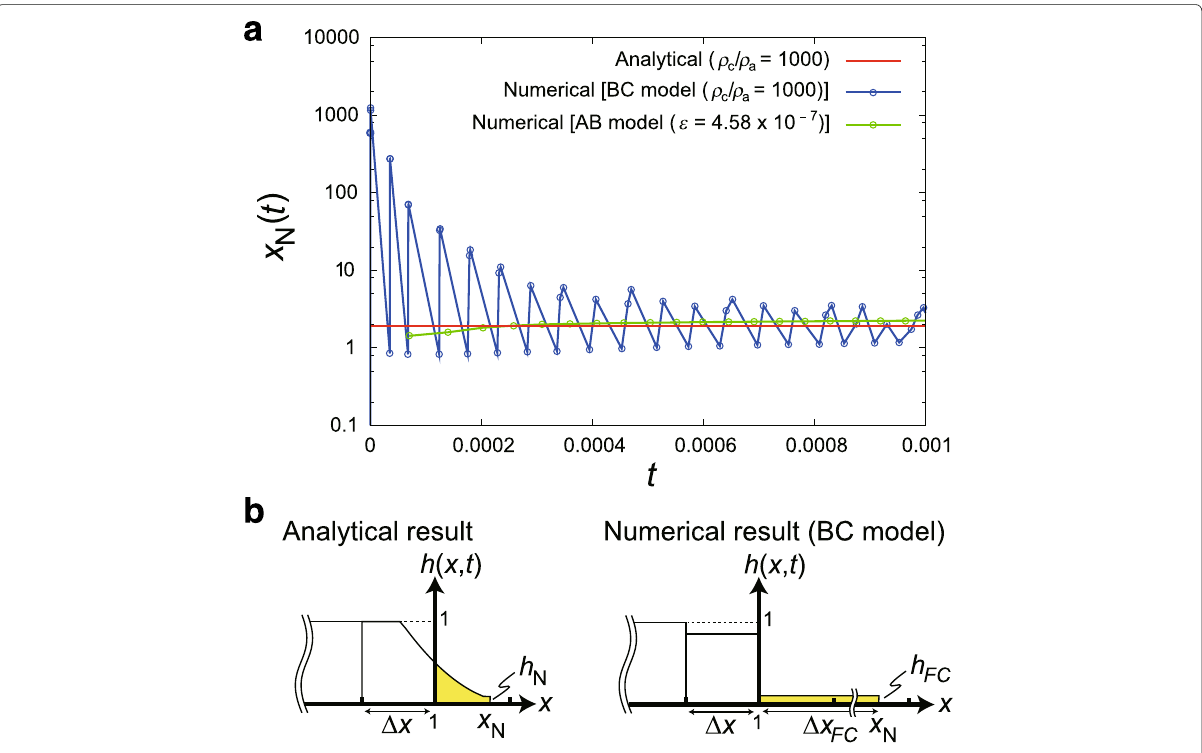
Fig. 7 Speed of the front position, ˙ x N , in the early time steps. a Comparisons between the analytical result with ρ c /ρ a = 1000 ( redline ) and numerical results of the BC model with ρ c /ρ a = 1000 ( bluesymbols ) and of the AB model with ε = 4.58 × 10 − 7 ( greensymbols ). In the numerical calculations, (cid:4) x = 1.0 × 10 − 4 . b Illustrations of the overestimation of ˙ x N by the BC model in t (cid:2) 0.0002 in ( a )